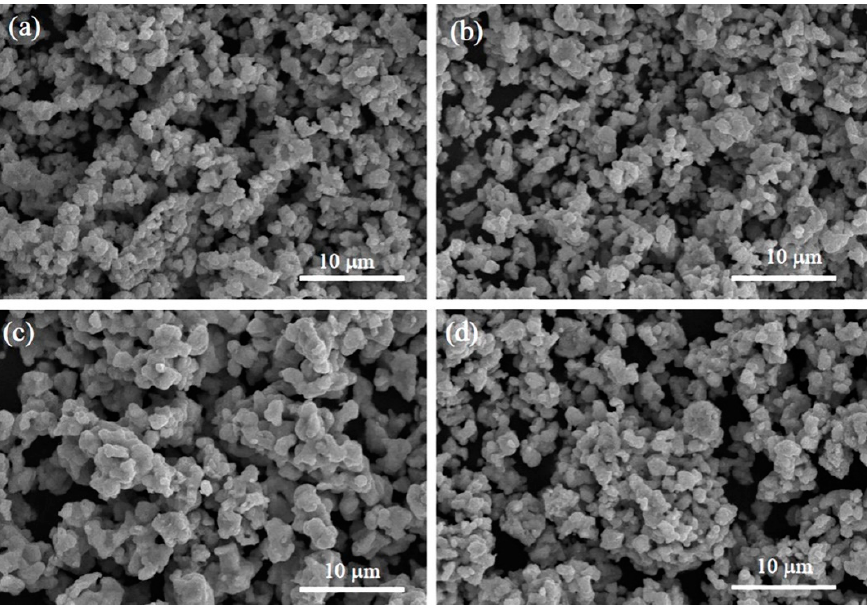
Figure 3. SEM images of samples A–D. ( a ) Sample A, ( b ) sample B, ( c ) sample C, and ( d ) sample D.